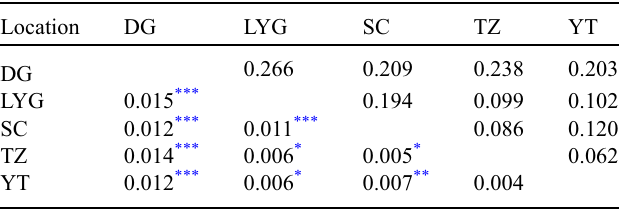
Table 2. Estimates of pairwise F ST values (below diagonal) and corrected average pairwise differences (Pi XY (cid:2) (Pi X þ Pi Y )/2 (above diagonal) among fi ve Larimichthys polyactis populations detected